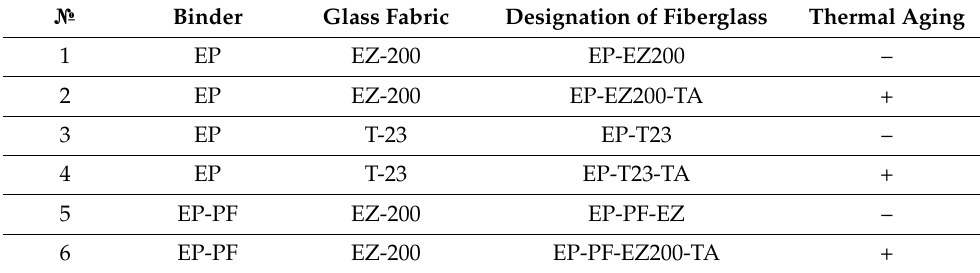
Table 4. Types of GRPs investigated.